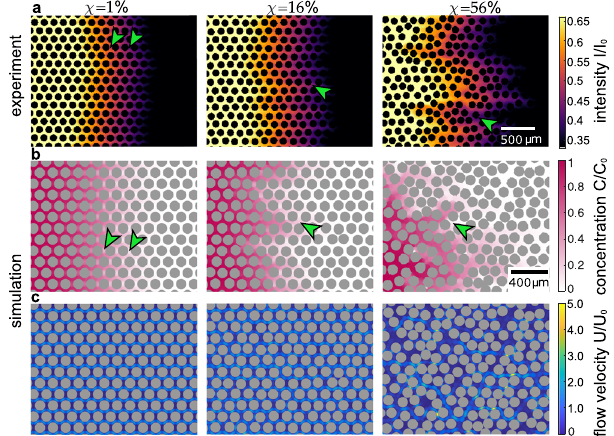
Fig. 2| Dispersiondynamicsdifferqualitatively withdisorder.a Visualisationof transportdynamicsinexperiments.Thetransportdynamicsofa fl uorescentsolute are visualised for porous media with varying pore-space heterogeneity. Distinct transportcharacteristicsemergefordifferentdegreesofpore-spaceheterogeneity for a Péclet number of Pe ∥ ≈ 30. Arrowheads highlight analogous dispersion char- acteristics between experiment and simulation. For χ =1%, these highlight the slower fi ll-up of the perpendicular pores, compared to adjacent parallel pores. For χ =16%thearrowheadspointoutthevaryingtransportdynamicsbetweenadjacent lanes of parallel pores, and at χ =56% they indicate extended regions of slower fi lling. b Visualisationoftransportdynamicsinsimulations.Thetransportdynamics are contrasted to numerical simulations. Distinct transport characteristics for dif- ferent degrees of pore-spaceheterogeneity are qualitativelyrecovered for a Péclet numberofPe ∥ ≈ 30andhighlightedwitharrowheads. c Visualisationof fl owpro fi les in simulations. For the simulation, the transport dynamics and the underlying fl ow pro fi les are compared. With increasing disorder, the heterogeneity in the fl ow pro fi les is increased. The normalisation U 0 denotes the average fl ow velocity in parallel pores, measured for a disorder of χ